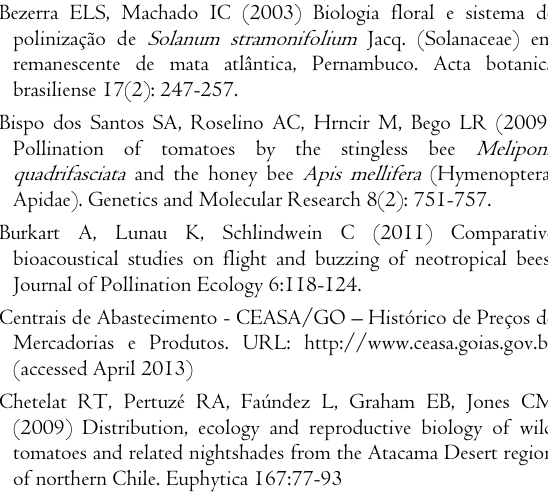
F IGURE 3. Relationship between seeds and tomato fruits